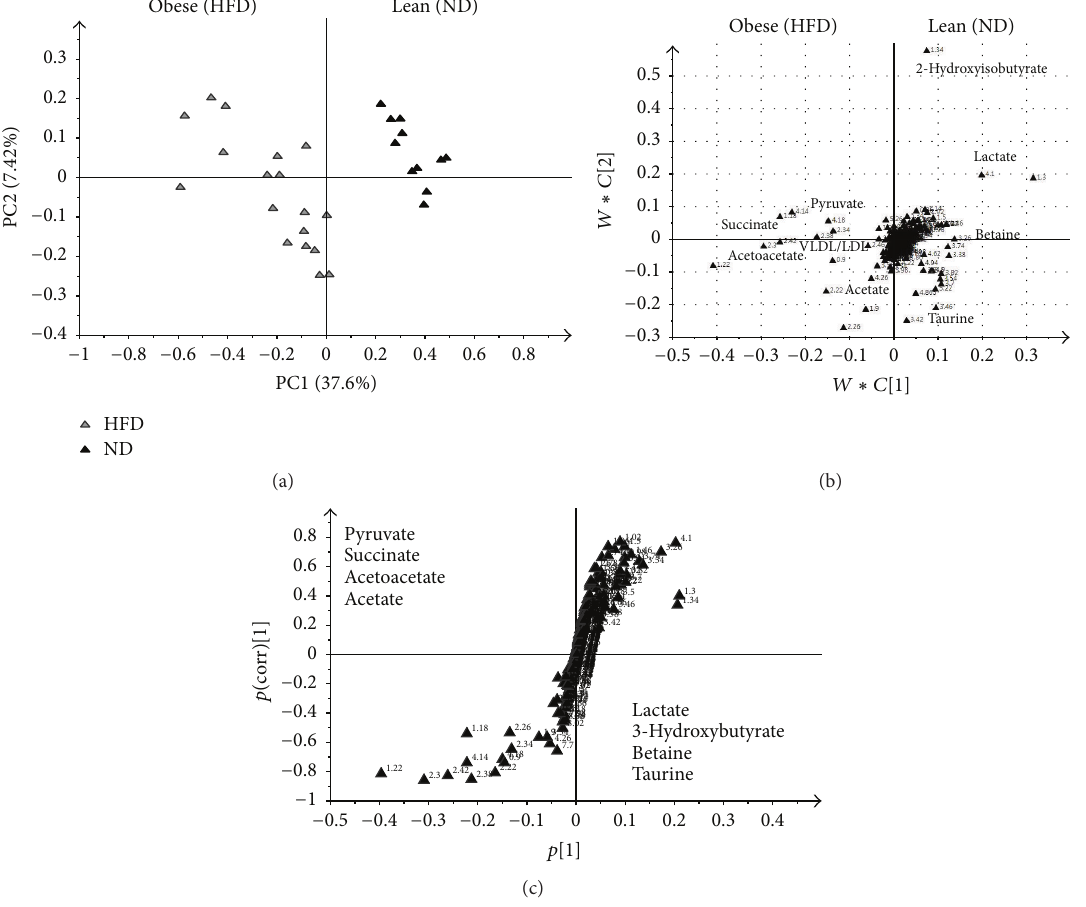
Figure 4: OPLS-DA derived score plot (a), loading plot (b), and 𝑆 plot (c) obtained using 1 H NMR data for serum samples from Sprague- Dawley rats fed a high fat diet (HFD) or a normal diet (ND) for 12 weeks.